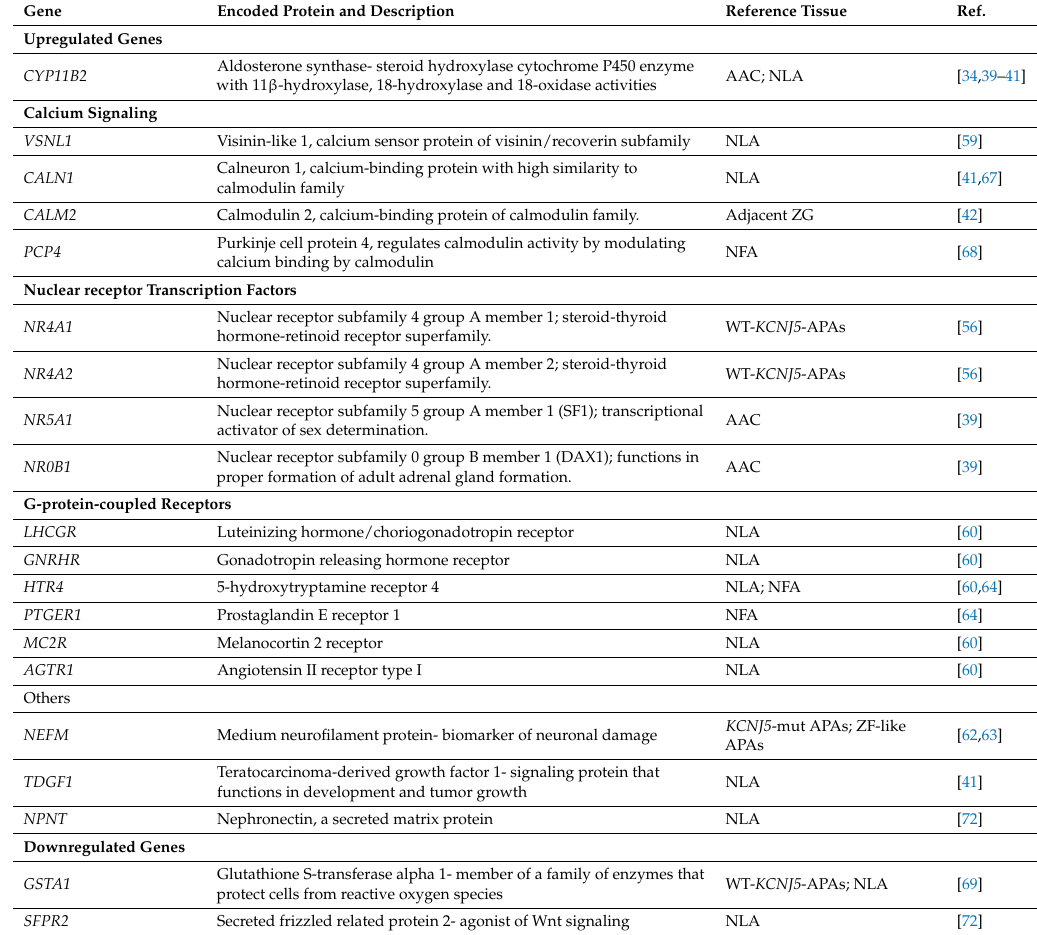
Table 2. Differentially expressed genes in aldosterone-producing adenomas and their reference tissues used in transcriptome